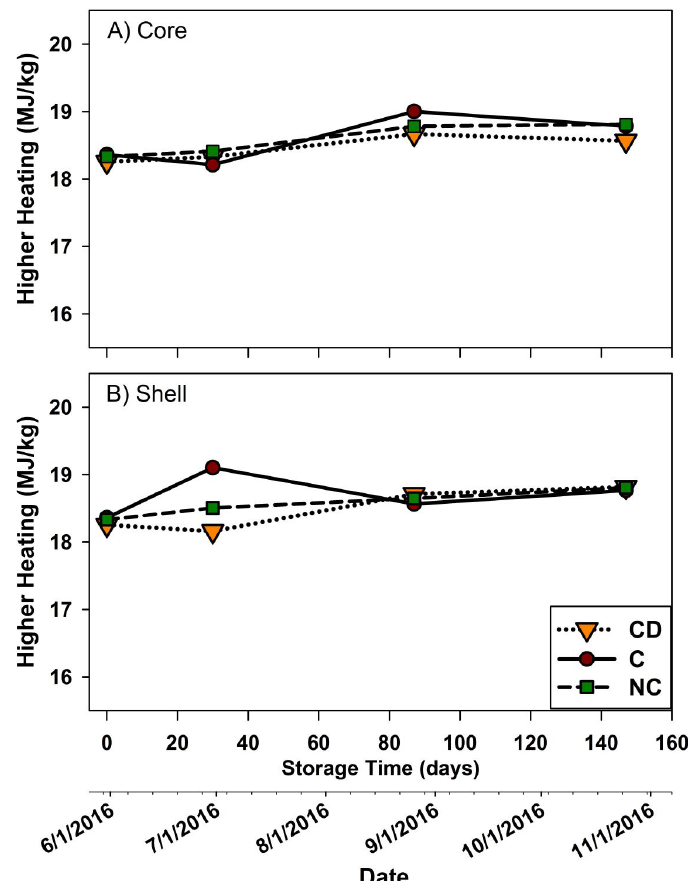
Figure 5. Variation of the higher heating value of willow and poplar wood chips stored for five months in piles with three different treatments (NC — no cover on pile; C — covered pile; CD — covered pile with dome ventilation); A) samples from the core; B) samples from the shell.